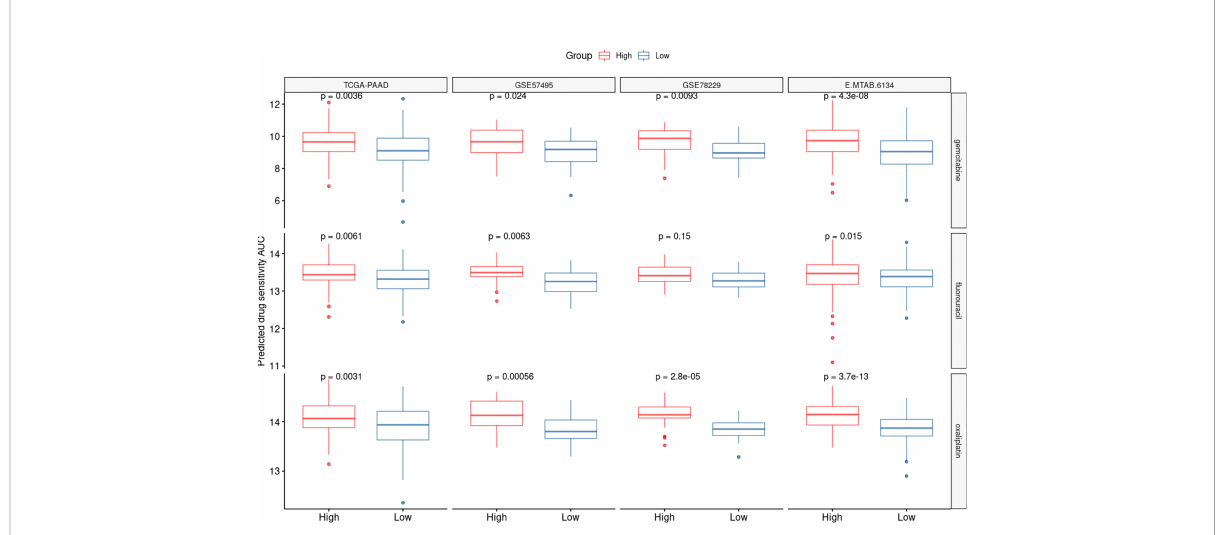
FIGURE 7 CAF-based signature is associated with chemotherapy response. The drug sensitivity of the high- and low-risk patients to three chemotherapy agents oxaliplatin, 5- fl uorouracil and gemcitabine was predicted using AUCs generated by OncoPredict. Lower AUC values represent higher